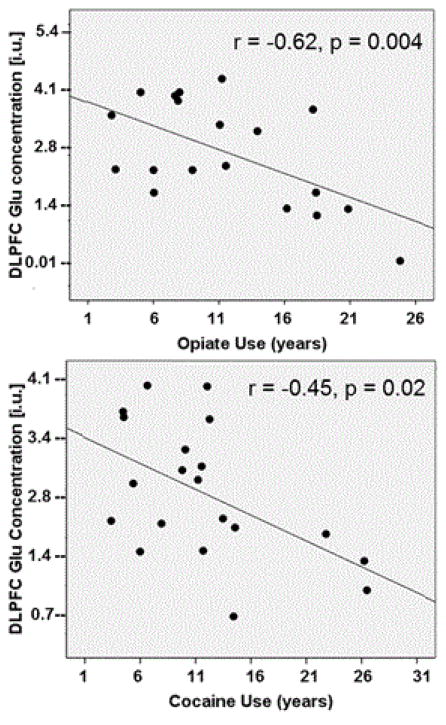
In OD, the associations of DLPFC Glu concentration (in institutional units, i.u.) with opiate and cocaine use.